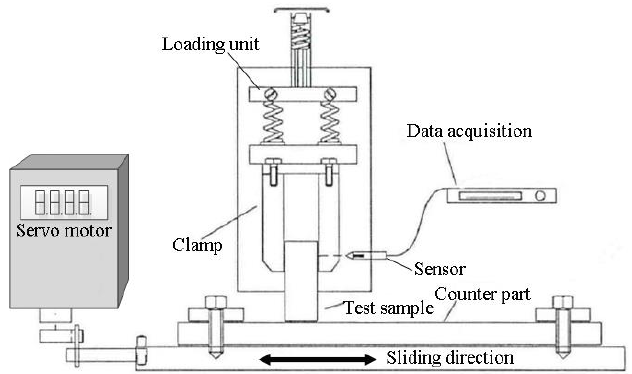
Figure 3. Schematic diagram of the tribo-tester.